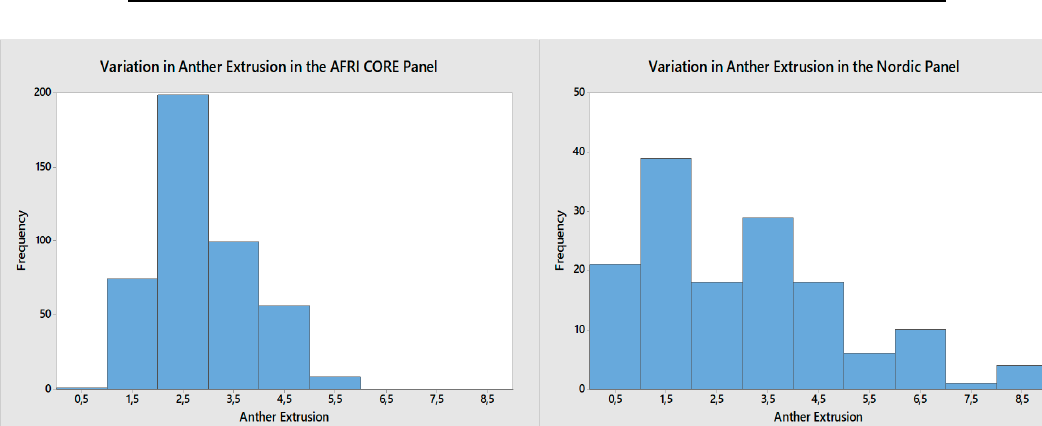
Figure 2. Distribution of anther extrusion versus deoxynivalenol content in the AFRI CORE oat population. Note the “fan shape” towards lower DON with higher AE, whereas low AE may have low to high DON levels, despite the limited range in AE. 3.1.2. The Nordic Screening Population There were significant differences between genotypes ( p < 0.001) for AE and a high correlation between replicates ( r = 0.78, p < 0.0001). The mean AE of genotypes ranged from 0 to 8.5 (Figure 1), with some large deviations at lower values. Most accessions (111 out of 140) had mean AE between zero and four, while only 14 accessions, one of which Stormogul, exceeded six. Cultivars Gere and Bessin, highly susceptible to FHB [28], had mean AE values of one. Anther extrusion was uncorrelated to DTF. Black lemma and high AE were associated in old genotypes. 3.2. The Variation and Inheritance in Anther Extrusion and Days to Flowering in the Recombinant Inbred Line Populations There were statistically significant differences between RILs ( p < 0.0001) for both AE and DTF in both populations (Table 2). AE showed continuous variation with transgressive segregation (not in the F × S population in 2012). This is consistent with an apparent heterosis in AE (score 8–9) and PH 5 10 15